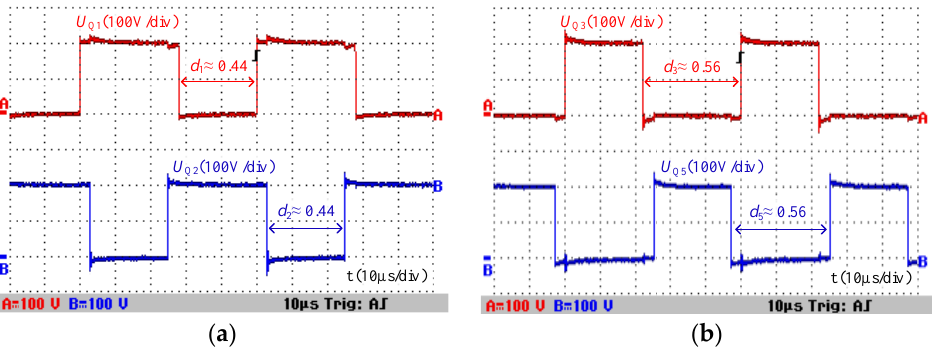
Figure 12. PWM voltages of power semiconductors; ( a ) U Q1 and U Q2 ; ( b ) U Q3 and U Q5 .